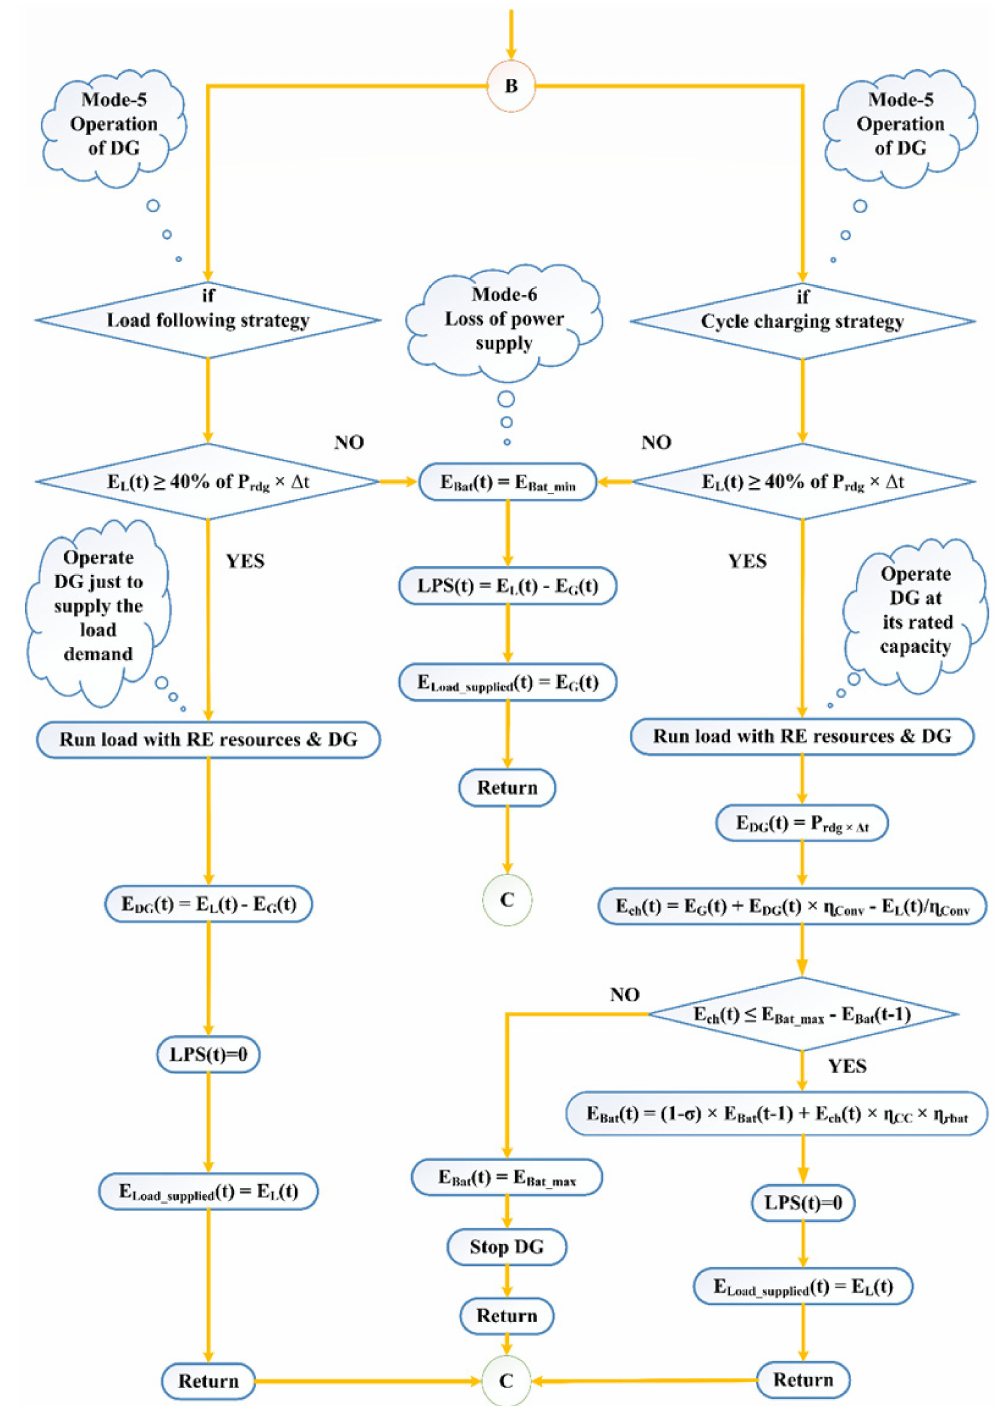
Figure 12. Flowchart of the EMS operating modes and acquisition of LPSP using LF and CC